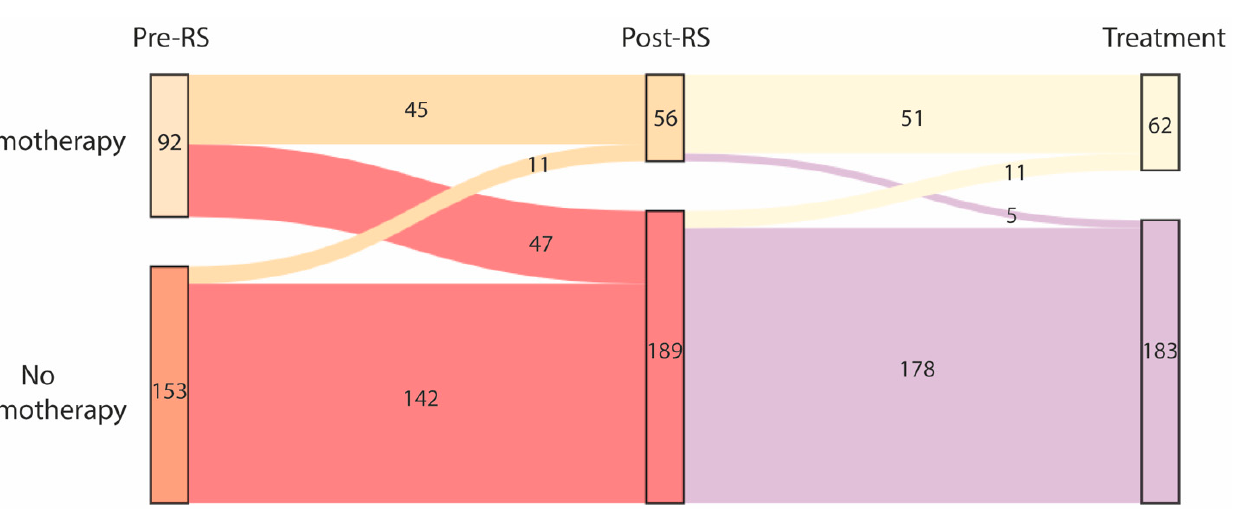
Figure 1. Correlation of Recurrence Score and Ki67: A clinical cut-off value for the Recurrence Score (RS) is ≥ 26 and for Ki67 is ≥ 20% (blue lines). Patients with concordant RS and Ki67 values are dis- played in green. Discordant RS and Ki67 values are highlighted in red. The yellow line extrapolates the correlation coefficient (Rho = 0.54).